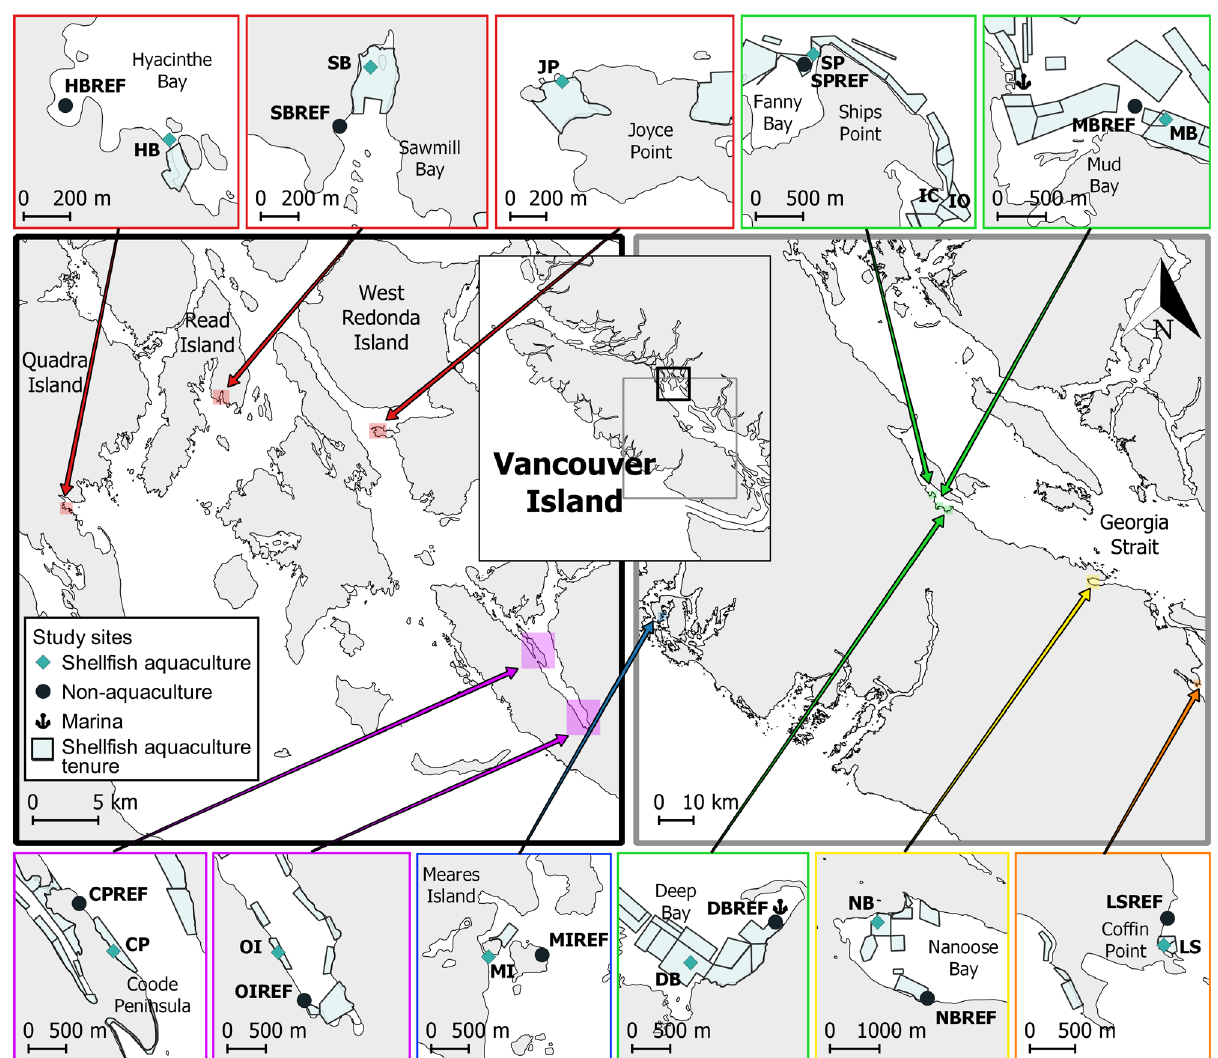
Fig. 1. Study area indicating the 6 regions key to the shellfish aquaculture industry in British Columbia where the study took place. Shellfish aquaculture tenures that have been leased from the government are indicated, but were not all necessarily in active use. Site of initial oyster and clam collection is indicated by IO and IC, respectively, both on the Ships Point panel. Dis- covery Islands (red)—HB: Hyacinthe Bay, HBREF: Hyacinthe Bay reference, SB: Sawmill Bay, SBREF: Sawmill Bay reference, JP: Joyce Point; Okeover Inlet (purple)—CP: Coode Peninsula, CPREF: Coode Peninsula reference, OI: Okeover Inlet, OIREF: Okeover Inlet reference; Clayoquot Sound (blue)—MI: Meares Island, MIREF: Meares Island reference; Baynes Sound (green)—SP: Ships Point, SPREF: Ships Point reference, MB: Mud Bay, MBREF: Mud Bay reference, DB: Deep Bay, DBREF: Deep Bay reference; Nanoose Bay (yellow)—NB: Nanoose Bay, NBREF: Nanoose Bay reference; Ladysmith (orange)—LS: Ladysmith, LSREF: Ladysmith